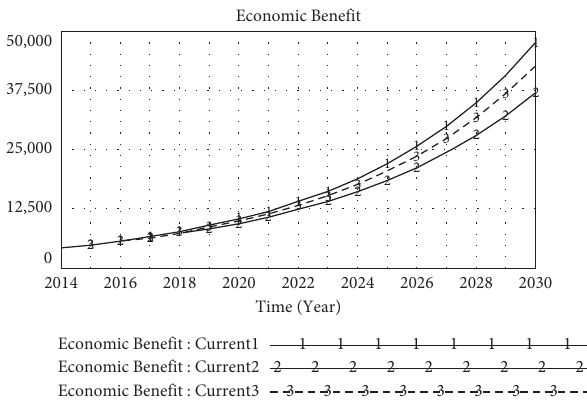
Figure 9: The influence of organizational factors adjustment on economic benefits.